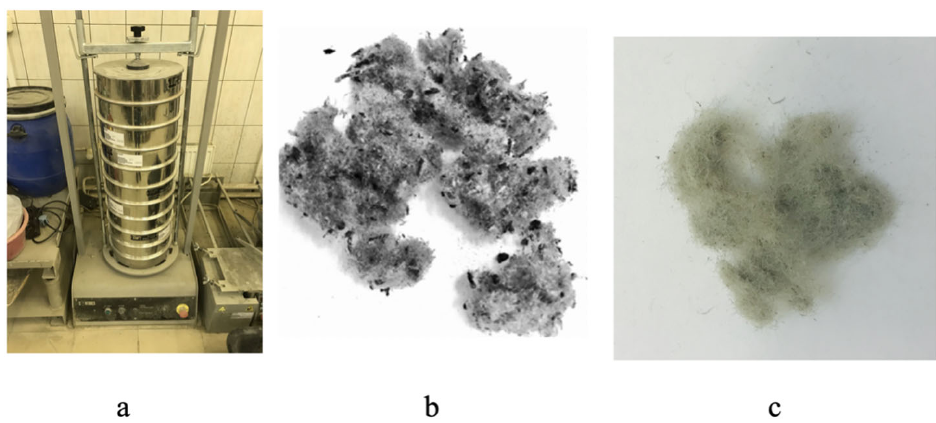
Figure 2. Stage of treatment of recycled tyre polymer fiber.